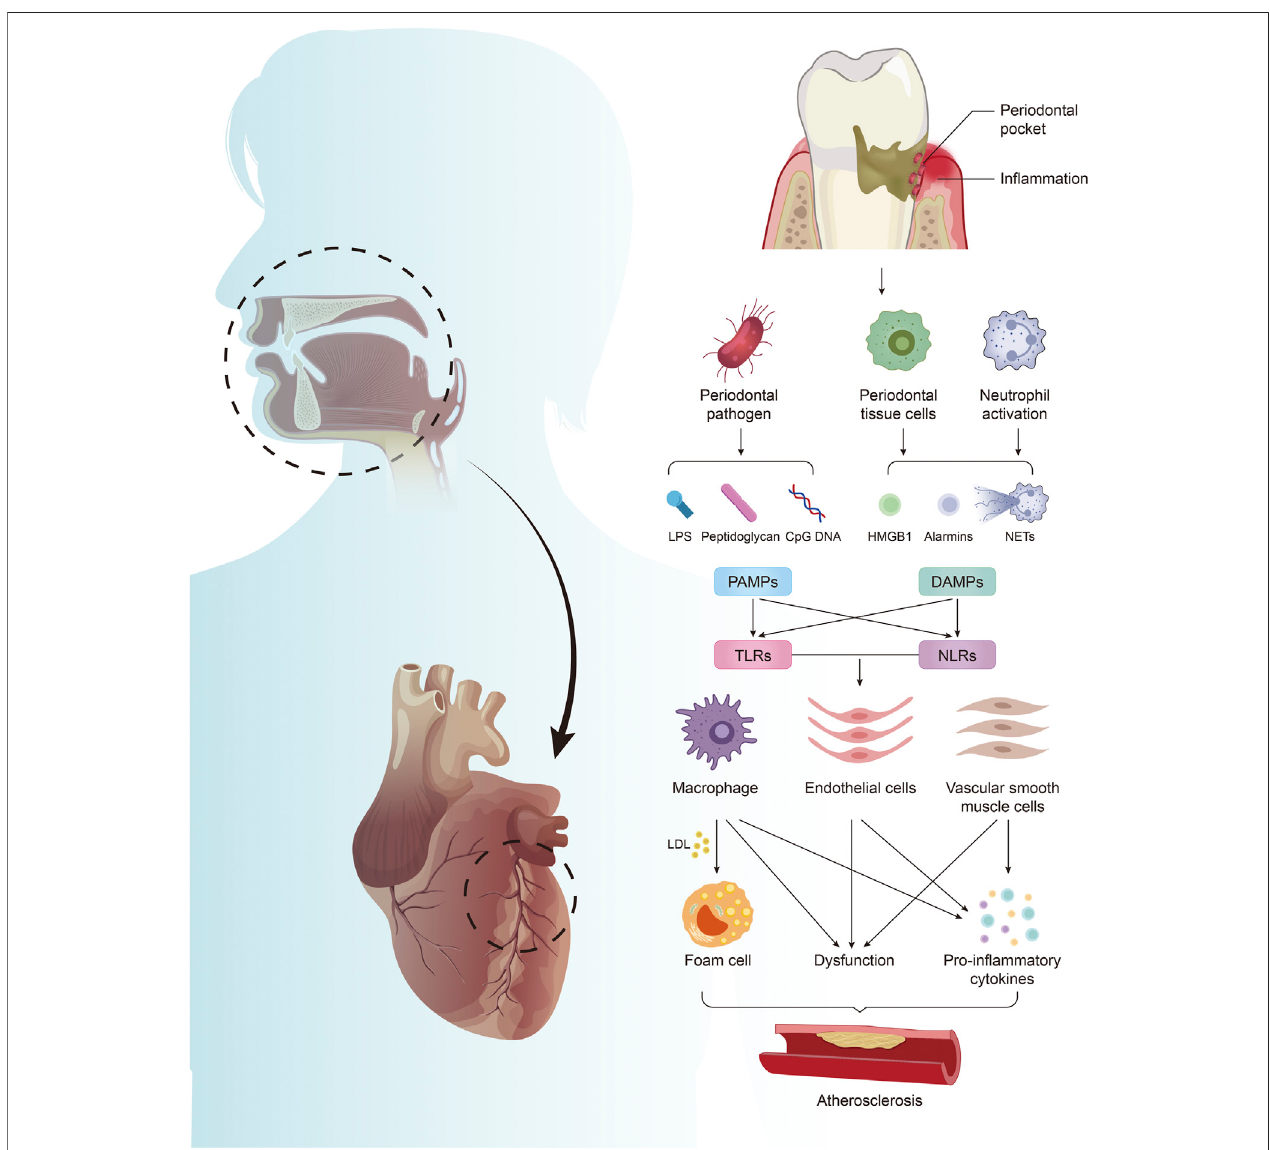
FIGURE 1 | Periodontitis mediates the formation of atherosclerosis by producing PAMPs and DAMPs. Periodontal pathogens produce PAMPs, including LPS, PGN, and CpG DNA. Periodontal infection activates neutrophils to form NETs, which together with HMGB1 and alarmins released by damaged periodontal cells constitute DAMPs. PAMPs and DAMPs activate excessive innate immunity by acting on TLRs and NLRs in arterial tissue, leading to foam cell formation, endothelial cell and vascular smooth muscle cell dysfunction, and promoting the massive release of in fl ammatory factors, which are involved in the regulation of AS.